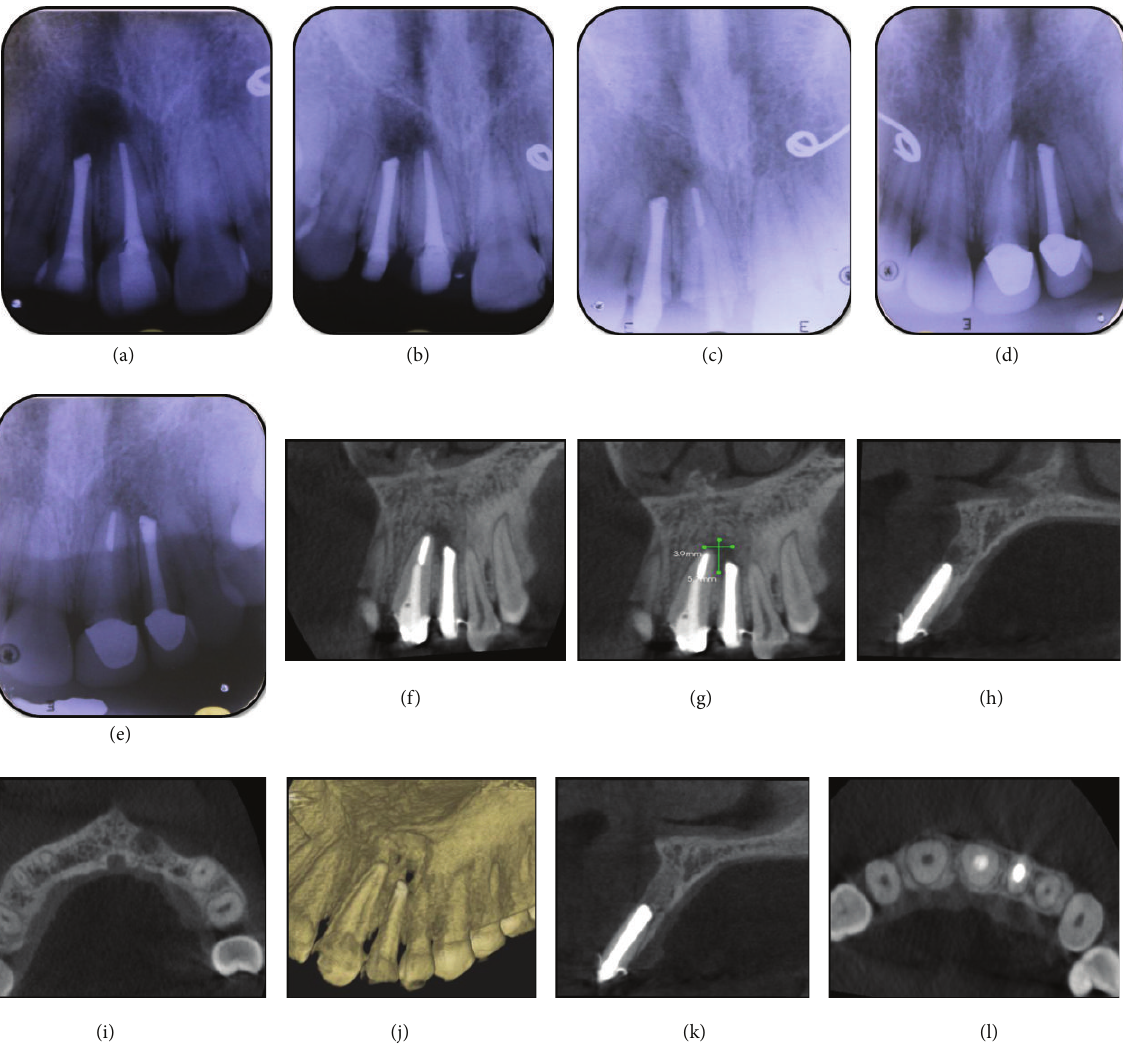
Figure 3: (a) IOPA radiograph at one month. (b) IOPA radiograph at three months. (c) IOPA radiograph at six months. (d) IOPA radiograph at one year. (e) IOPA radiograph at two-year followup. (f) Coronal plane CBCT image showing decreased size of periapical lesion at six months. (g) Coronal plane CBCT image showing measurement of periapical lesion; dimensions 5.7 mm/3.9mm. (h) Sagittal plane CBCT image showing decrease in size of periapical lesion at six months. (i) Axial plane CBCT image showing decrease in size of periapical lesion at six months. (j) Three-dimensional CBCT image showing periapical lesion six months. (k) Sagittal plane CBCT image showing status of MTA obturation at six months. (l) Axial plane CBCT image showing status of root-canal filling at six